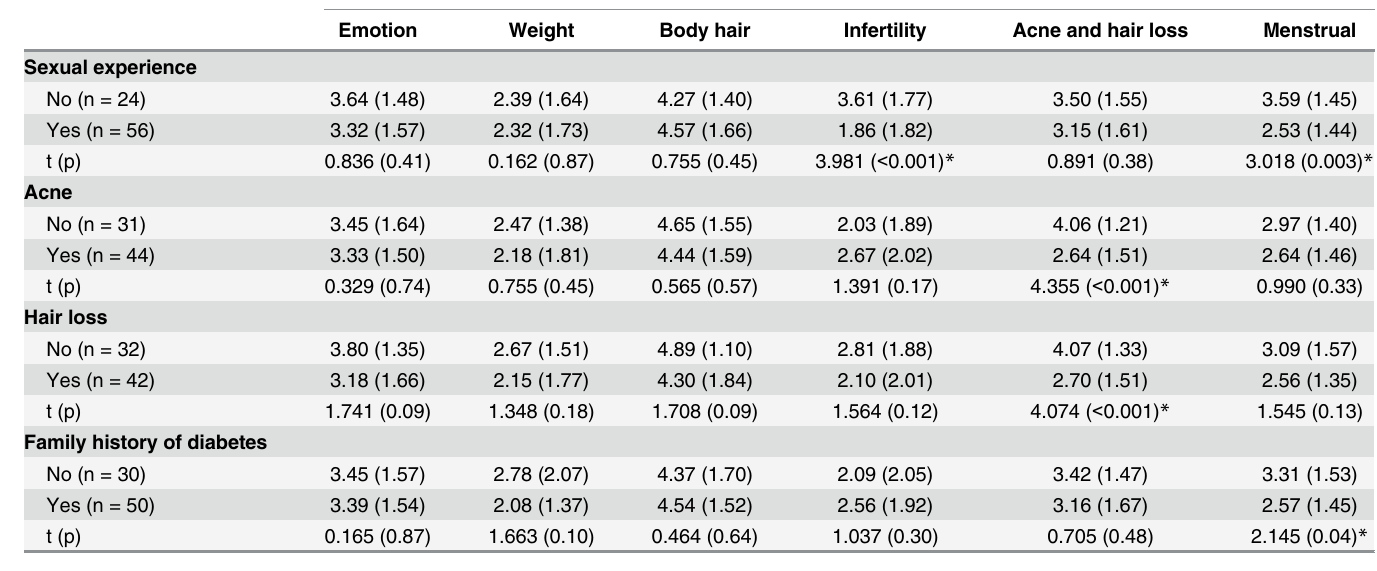
Domain score: Mean (standard